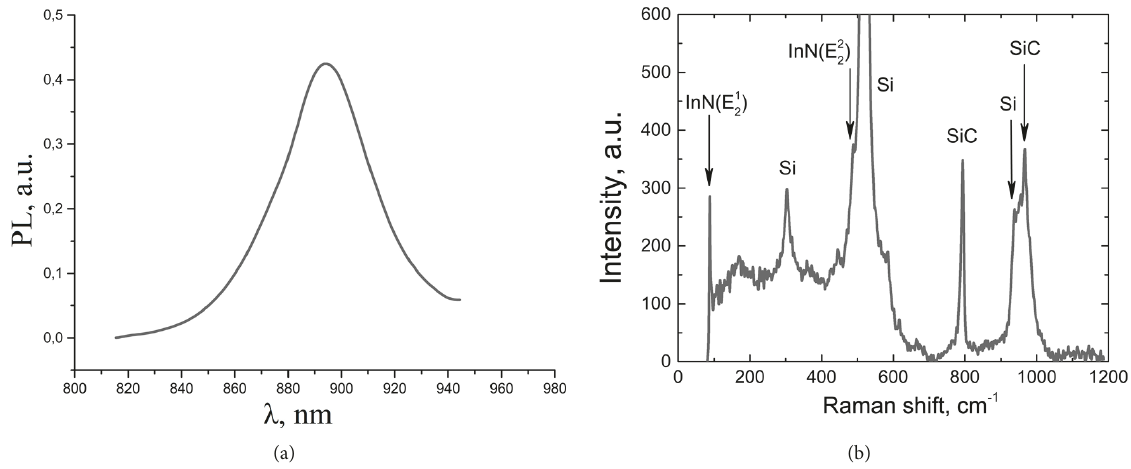
Figure 6: Typical RT PL (a) and Raman spectra (b) of InN NWs grown on SiC/Si hybrid substrate.